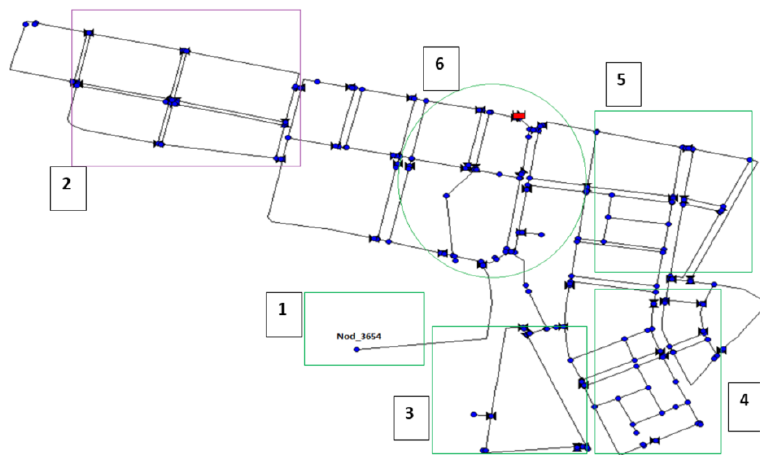
Figure 5. Areas of the contaminant locations.